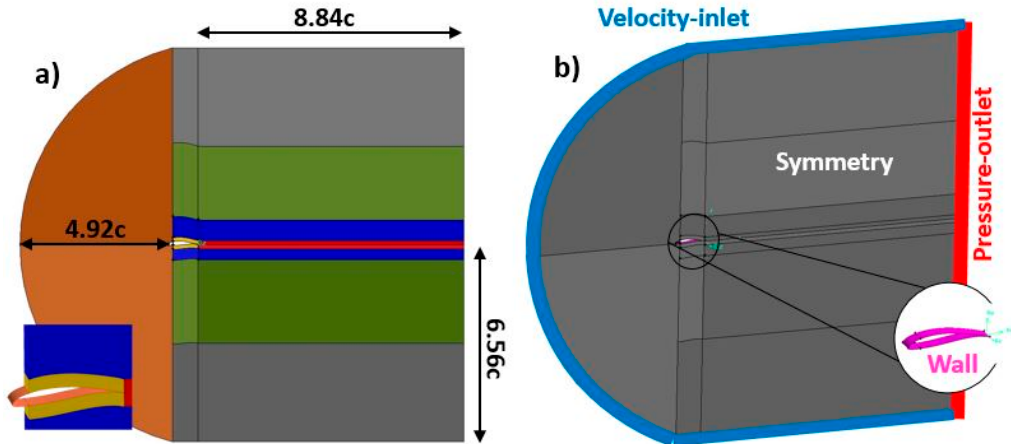
Figure 2. Numerical domain. ( a ) Upstream and downstream extension. ( b ) Boundary conditions.